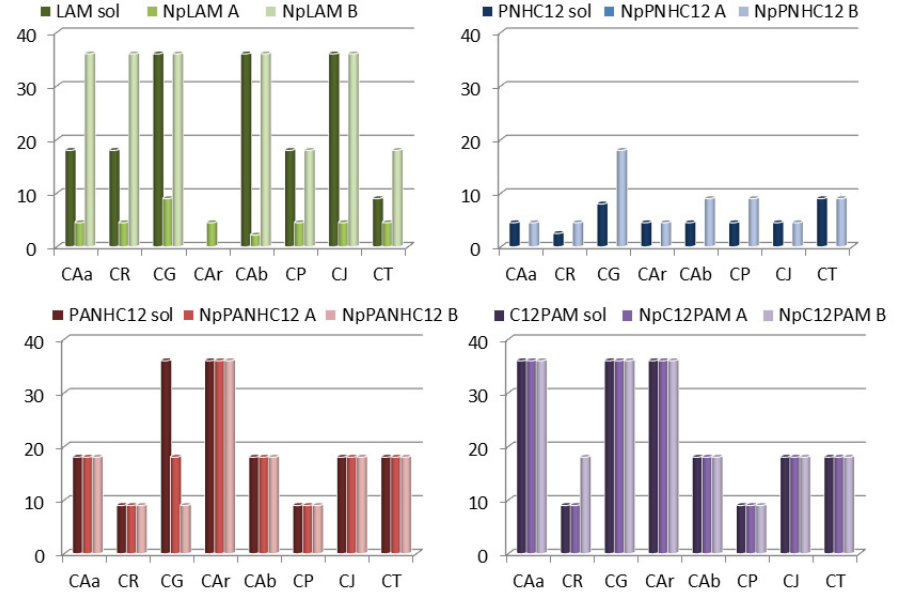
Figure 12. Determination of the MIC ( µ g/mL) for LAM, PNHC 12 , PANHC 12 and C 12 PAM